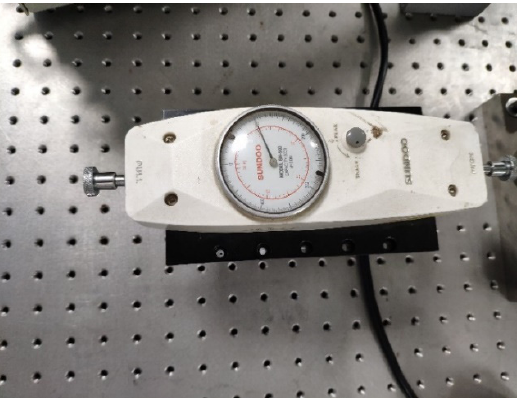
Figure 19. Picture of pointer thruster.